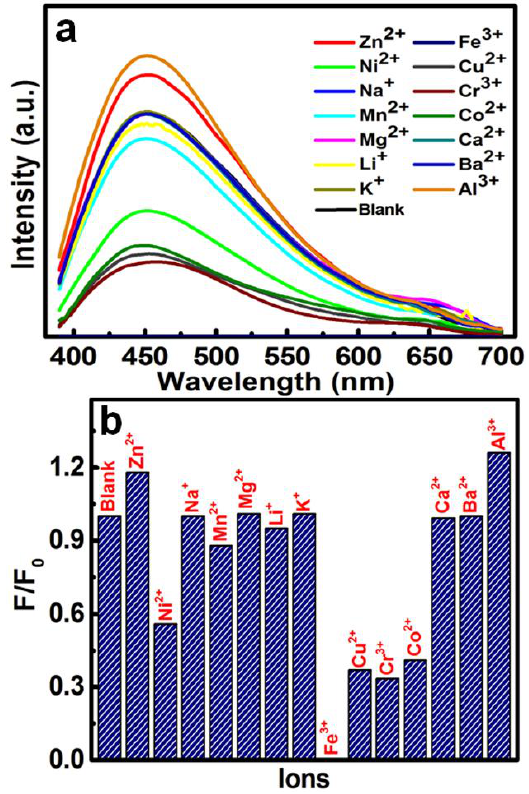
Figure 7. ( a ) Fluorescence responses of the CQDs-120 with different metal ions of 1 mM, and ( b ) corresponding F / F 0 with the different metal ions as indicated. F 0 and F are the fluorescence intensity before and after addition of the Fe 3+ ion.